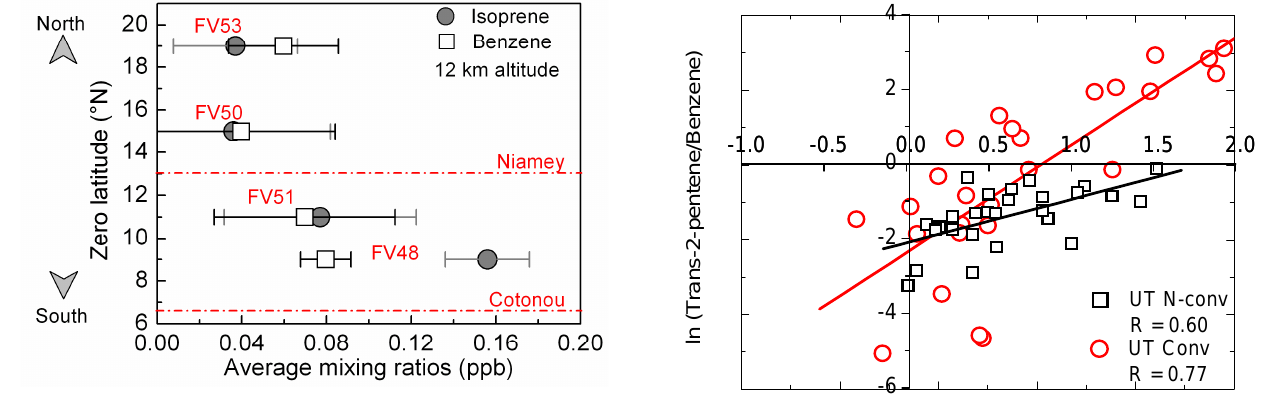
Fig. 7. Average UT content (FV48: 4 data points, FV50: 4 data points, FV51: 4 data points, FV53: 5 data points) of isoprene (round marker) and benzene (squared marker) according to latitude zero. Bars indicate standard deviations.